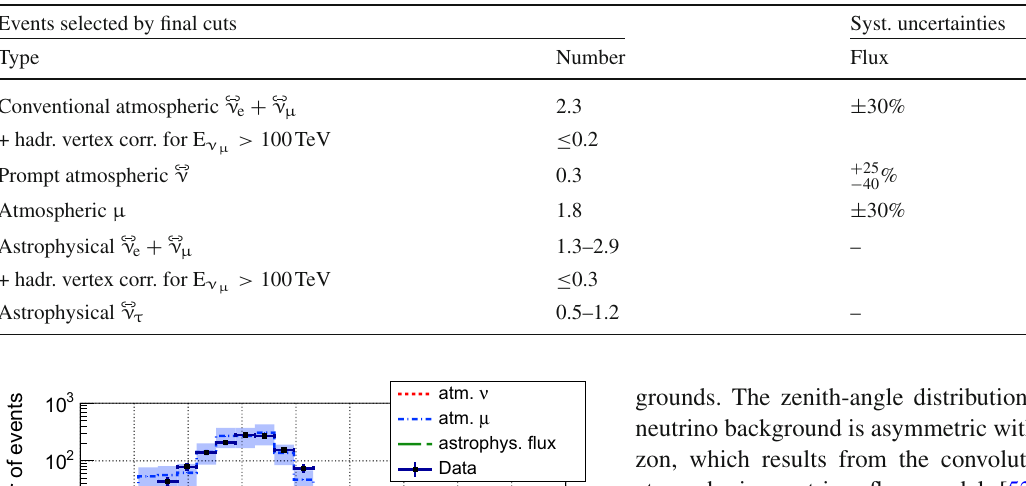
Table1 Eventnumberexpectationscorrespondingto1247daysofdata taking for the diffuse neutrino flux search derived from simulations for signal and background events. The range for the astrophysical event numbers corresponds to the fluxes as reported in Refs. [5,6], respec- tively. Event numbers for a given neutrino flavour denote the sum of